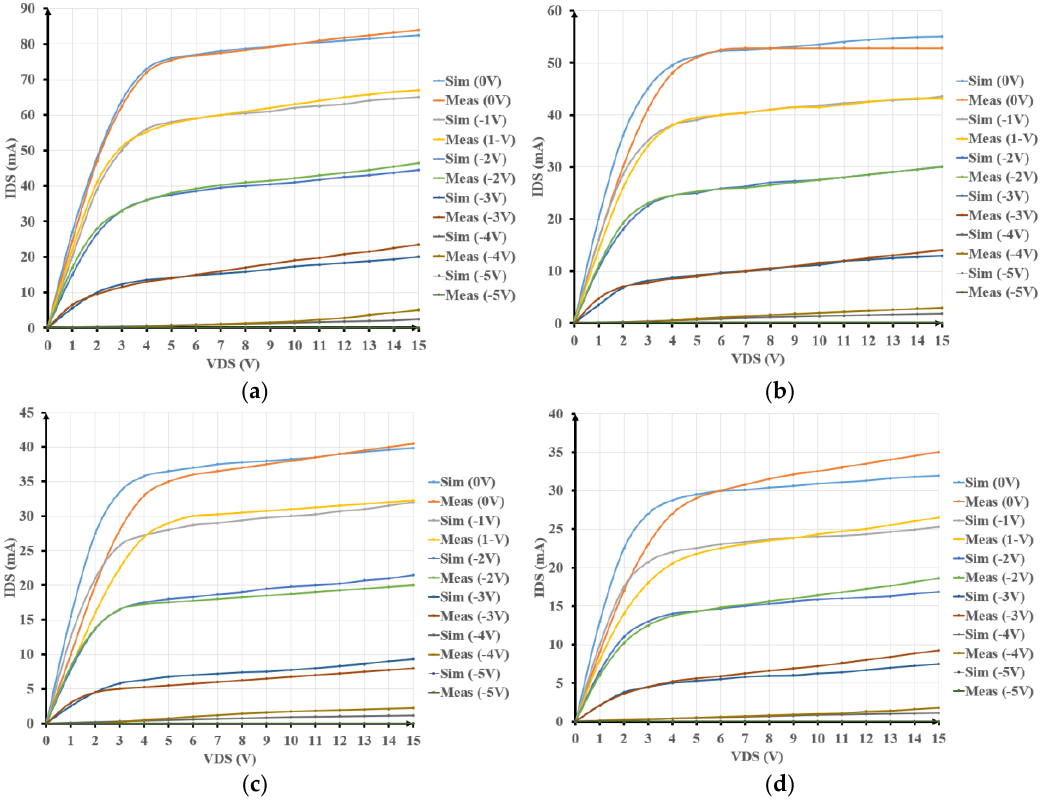
Figure 3. Measured and simulated I-V characteristics of a GaN500 device at: ( a ) 25 °C; ( b ) 200 °C; ( c ) 300 °C; ( d ) 350 °C.